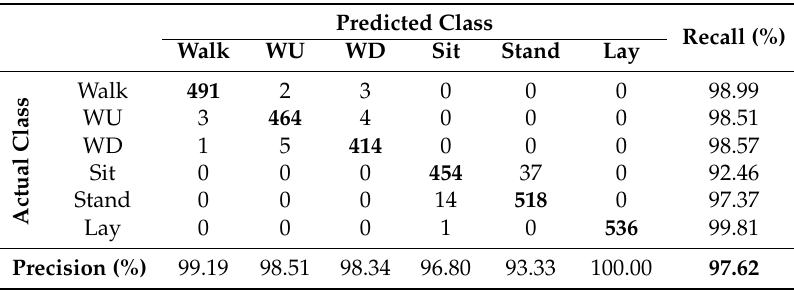
Table 7. Confusion matrix of our CNN+Sharpen approach on UCI HAR dataset. The bold numbers in diagonal indicate correctly classified instances; the bottom right bold number indicates the overall accuracy.